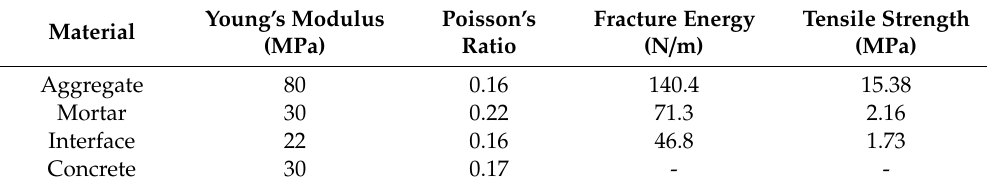
Figure 17. Schematic diagram of the aggregate placement and the aggregate element for simulation. ( a ) Aggregate geometry and ( b ) aggregate elements. Table 7. Material parameters used in the analysis.